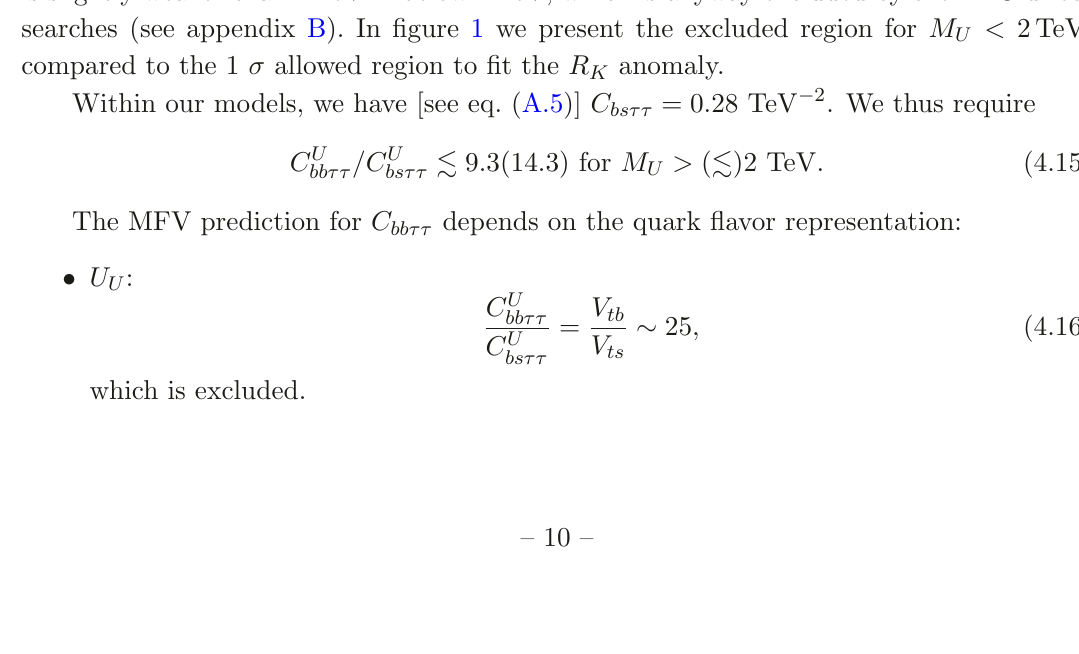
Figure 1 . Constraints in the M U R , the region excluded by the high- p T pp K ( ∗ ) direct searches (see appendix